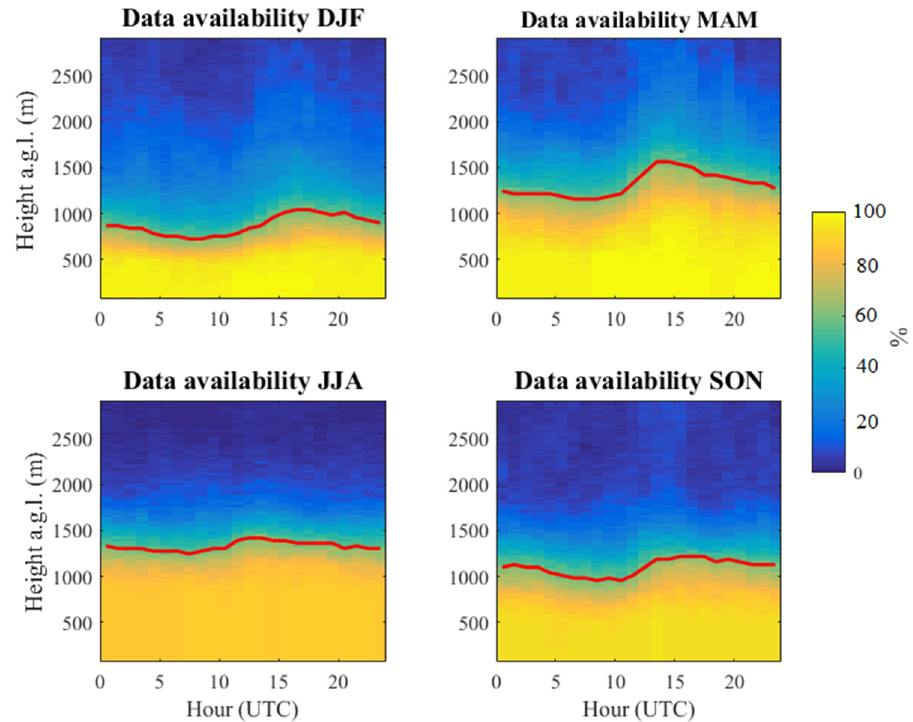
Figure 2. Fraction of available data from 3 May 2016 to 2 May 2018, divided by hours and range gates. Red lines stand for the heights where data availability drops to 60%.